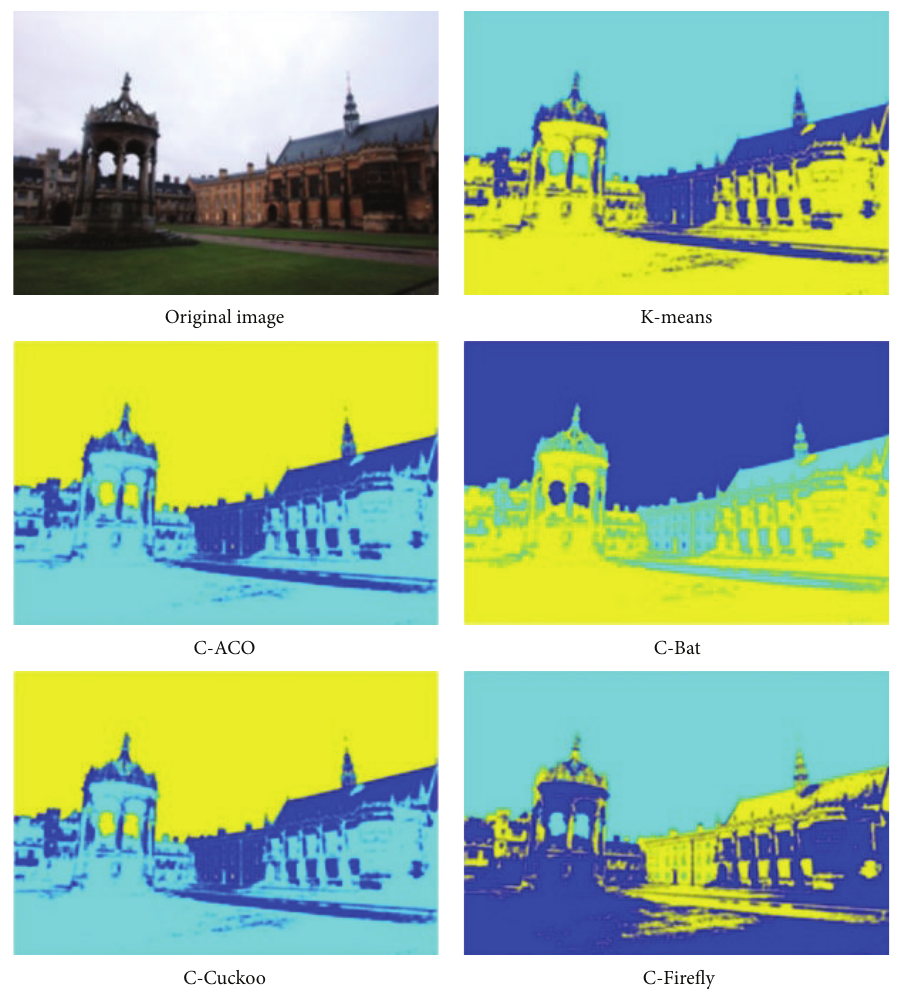
Figure 10: Results of image segmentation by using different nature-inspired clustering algorithms, on a photo called “Cambridge University.”